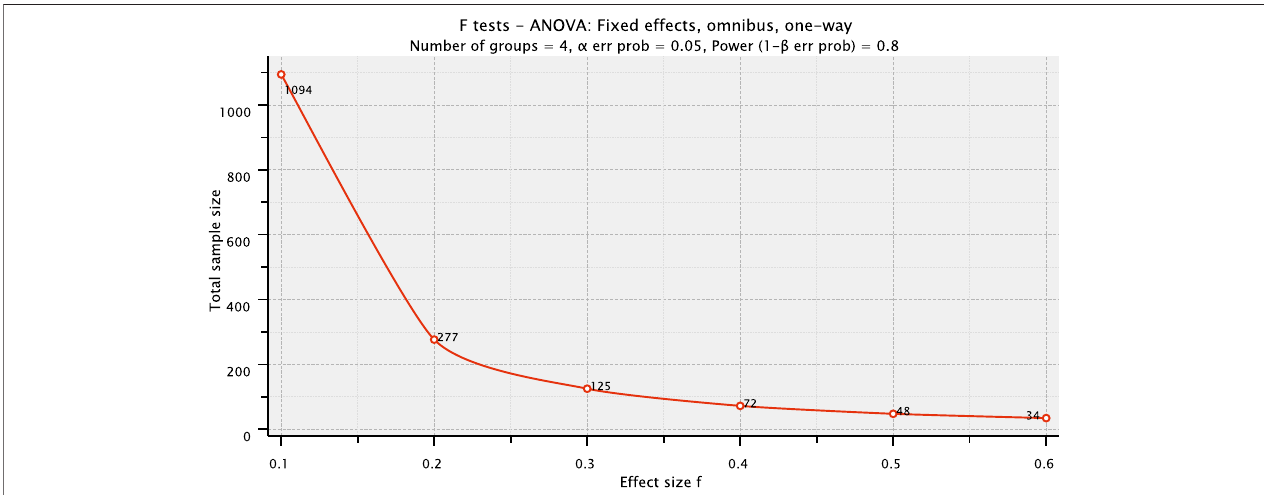
FIGURE2| G*POWERplotofthetotalsamplesize(y-axis)dependingontheeffectsizefexpected(x-axis)afterestablishingtheparameters:numberofgroups=4; α error probability= 0.05, and power (1- β error probability) = 0.80. The total sample size indicated includes the four groups. The effect size f range plotted covers small (0.1), medium (0.2), and large (0.4 or higher) effects for ANOVA, as established by Cohen (1969).